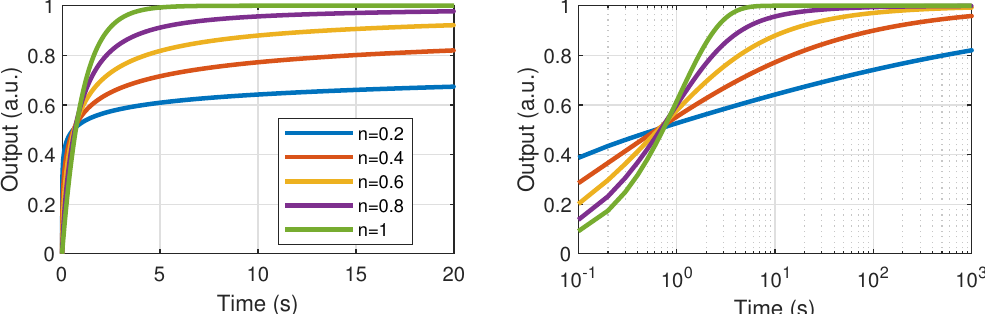
Figure 5. Step responses of fractional order unit relaxors ( n is the fractional order). ( Left ) linear time scale; ( Right ) logarithmic time scale (a.u. refers to “arbitrary units”; “Input” and “Output”, respectively, refer to the input and output signal of the system represented by the transfer function H ( s ) (i.e., in ( s ) and out ( s )